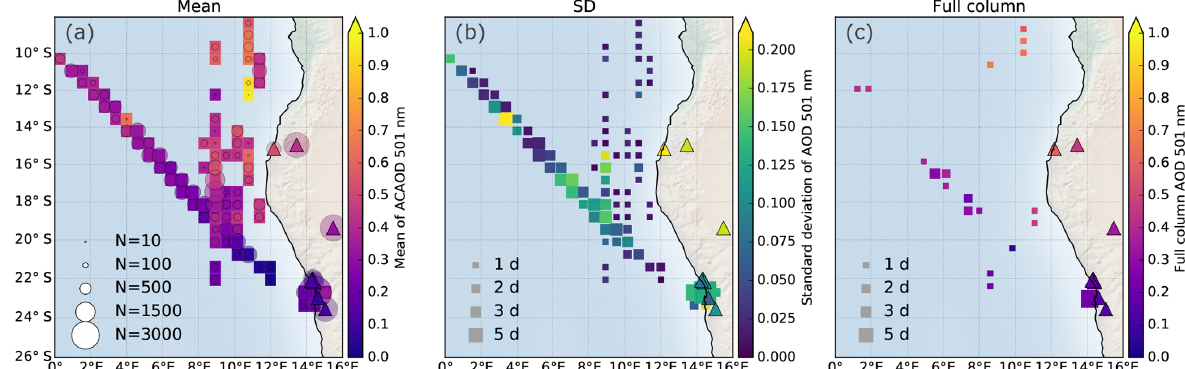
Figure 5. (a) Map of mean ACAOD 501 from all P-3 flights, spatially binned during ORACLES 2016 deployment period. The triangles indicate the location of the ground-based AERONET stations, colored by their average full-column fine-mode AOD 501 . The overlaid circle size denotes the number of individual samples within that bin. (b) The standard deviation of ACAOD 501 within each bin with the size of the squares denoting the number of days (abbreviated as “d”) sampled within each bin. The legend in the bottom left of (b) denotes the different sizes of the square symbol relating to the number of sampled days in each bin. The triangles indicate the standard deviation of the fine-mode AOD measured by the ground-based AERONET stations (from north to south): Lubango, Namibe, the DRAGON network at Henties Bay, Walvis Bay Airport, and Gobabeb. (c) The mean full-column AOD 501 measurements and their location, with size of the square denoting the number of days sampled. The associated AERONET locations in triangle are for the total (fine + coarse-mode)